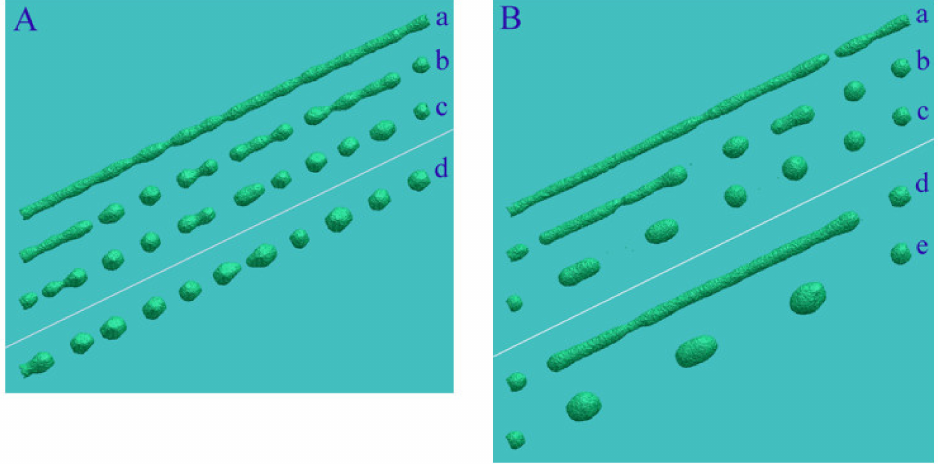
Figure 10. Breakup of nanowires with (111) orientation without external irradiation (subpart ( A )) and under conditions of stimulated surface diffusion of atoms (subpart ( B )): ( A ) α = 0.9, (cid:0) × (cid:1) p = 0.725, L = 1050. Configurations (a–c) r nw = 12.5; t = 3.0, 4.2, 5.4 10 6 MC steps. Con- (cid:0) × (cid:1) figuration (d) r nw = 14.5; t = 9.45 10 6 MC steps; ( B ) α = 0.9, p = 0.8, L = 1050. Config- (cid:0) × (cid:1) urations (a–c) r nw = 12.5; t = 3.0, 4.8, 7.2 10 6 MC steps. Configurations (d,e) r nw = 14.5; (cid:0) × (cid:1) t = 12.0, 26.1 10 6 MC